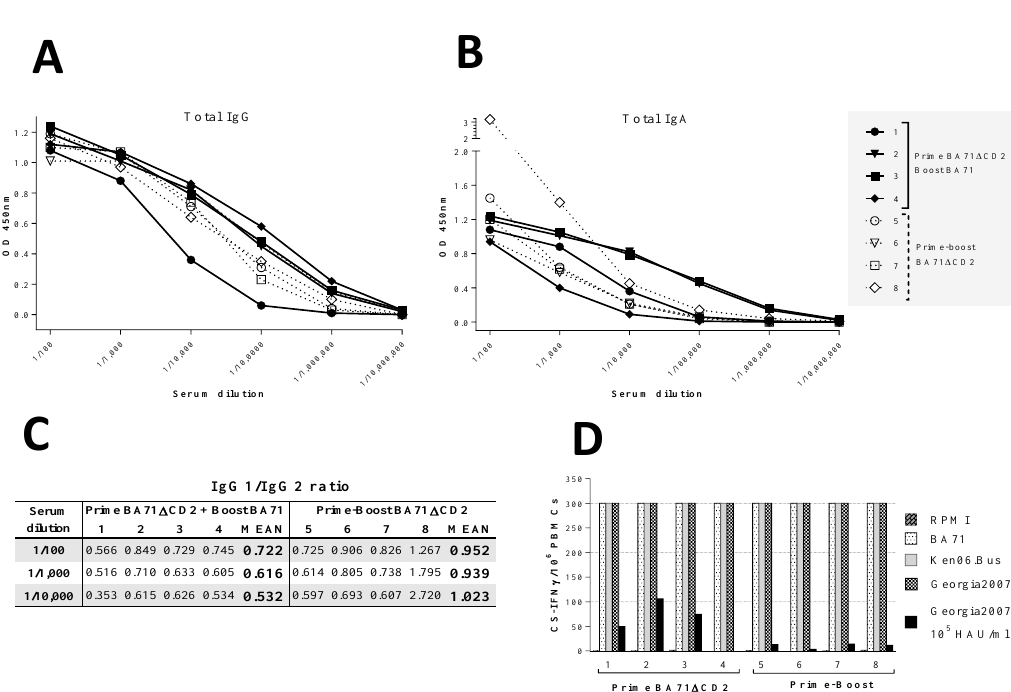
Figure 3. ASFV-specific IgG ( A ) and IgA ( B ) titers found in the blood of pigs at the time of Ken06.Bus challenge, and ASFV-specific IgG1 / IgG2 ratios ( C ) and IFN γ -secreting specific T cells found in peripheral blood mononuclear cells (PBMCs) in vitro stimulated with 10 6 HAU / mL of BA71, Ken06.Bus, or Georgia2007 / 1. Additionally, PBMCs were stimulated with 10 5 HAU / mL of Georgia2007 / 1 ( D ) at this same time point; any sample scoring ≥ 300 spots / 10 6 PBMCs received a score of 300, which was considered the limit of our assay resolution. ASFV-specific antibodies and T-cells were measured by ELISA and ELISPOT (IFN- γ secreting cells), respectively.